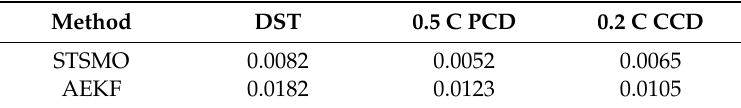
Figure 16. CSMO-based SOC estimation at different initial SOCs with large switching gain. Table 2. RSME of SOC estimation error.